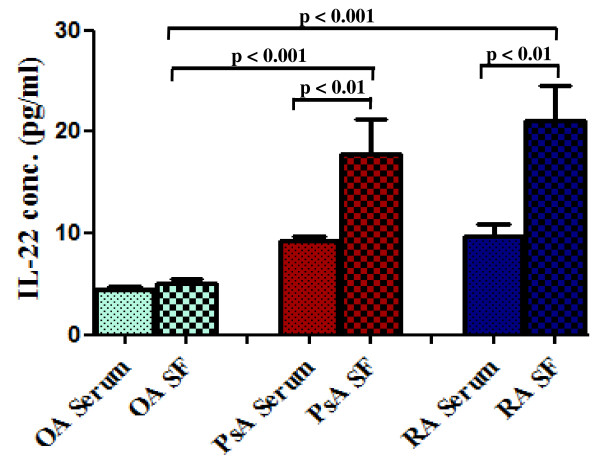
IL-22 in SF and serum of PsA and RA were elevated compared to OA patients. Synovial fluid (SF) and peripheral blood (PB) were collected from psoriatic arthritis (PsA, n = 15), rheumatoid arthritis (RA, n = 15) and osteoarthritis (OA, n = 15) patients. IL-22 levels were measured in SF and serum samples by ELISA. All experiments were done in triplicate. Results were expressed as Mean ± SEM. Nonparametric tests; Mann Whitney and Kruskal Wallis ANOVA with Dunn's multiple comparison tests were used to determine statistical significance.